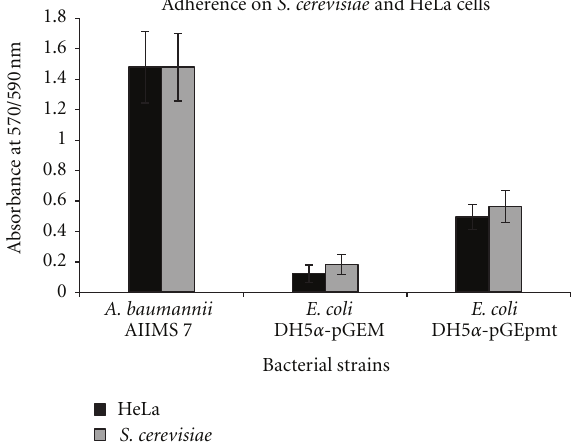
Figure 6: Quantitative analysis of adherence and biofilm formation on biotic surfaces ( S. cerevisiae and HeLa cells). (Absorbance values normalized with blank medium, P < 0 .